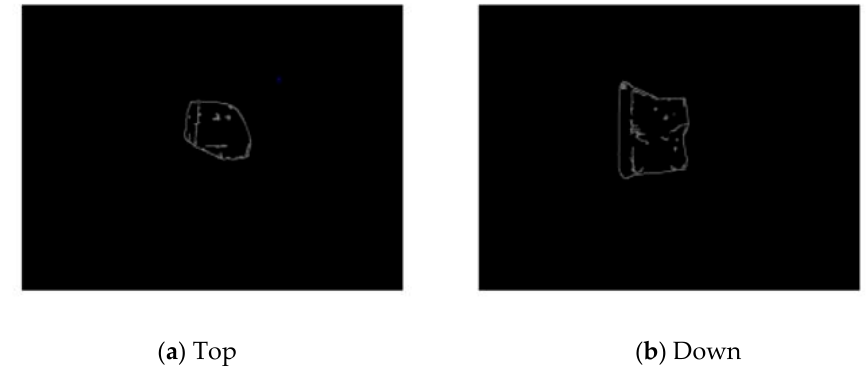
Figure 2. Canny edge detection.